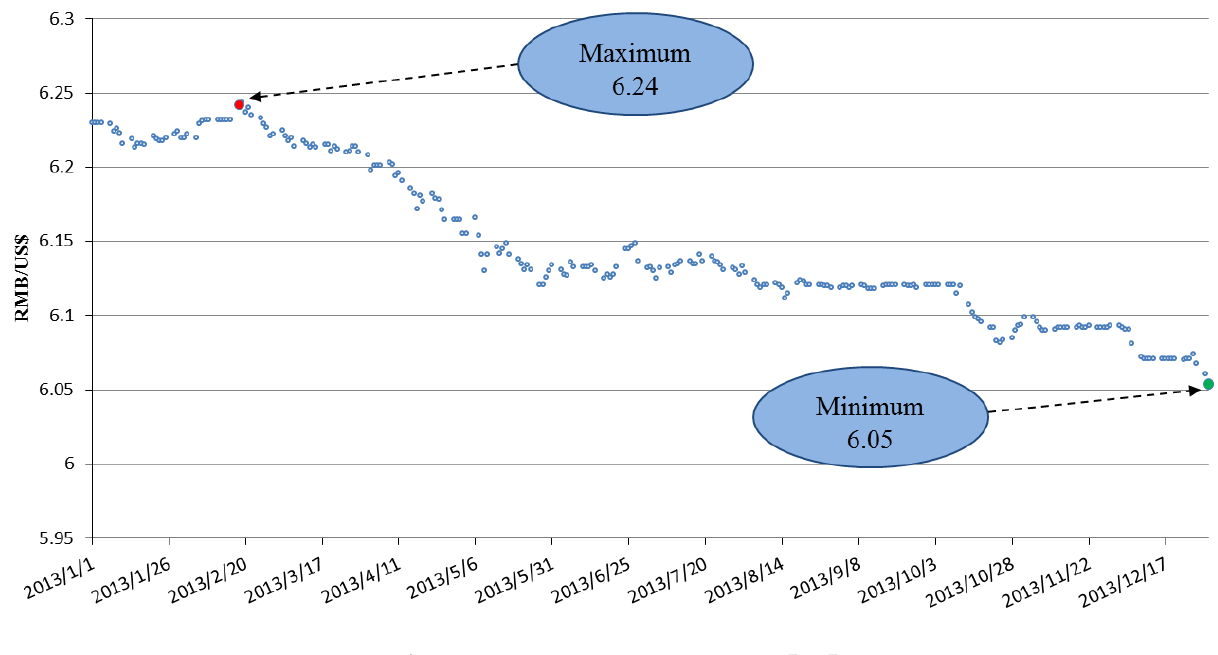
Figure 7. Chinese exchange rate